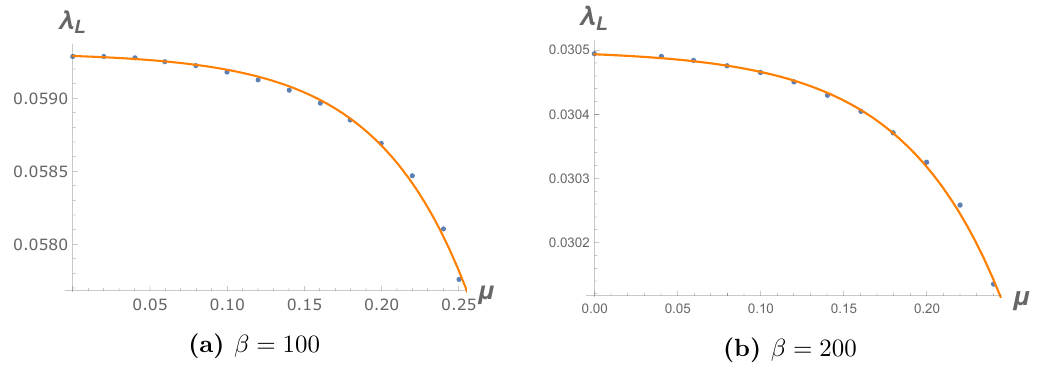
Figure 7. Lyapunov exponent as a function of the chemical potential for (cid:12)xed temperature. The plots (cid:12)t exponential functions very well. The (cid:12)ts for (a) is 0 : 05931 (cid:0) 0 : 0000209 (cid:2) e 17 : 06 (cid:22) and (b) is 0 : 03050 (cid:0) 6 : 245 (cid:2) 10 (cid:0) 6 e 16 : 86 (cid:22)